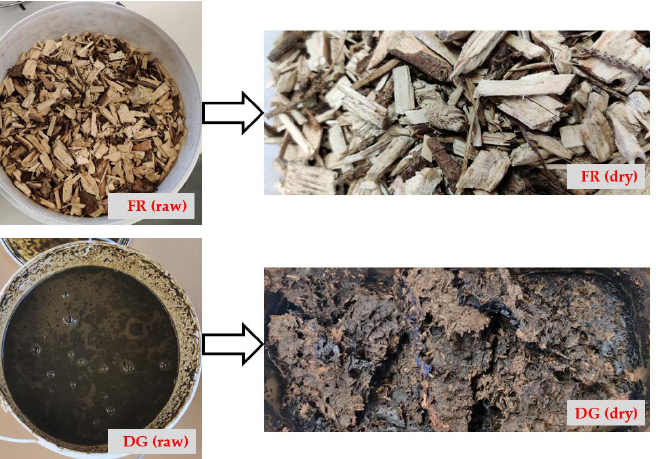
Figure A1. Raw materials used in this study: softwood-based forest residue (FR) and digestate (DG); left pictures: samples as provided; right pictures: samples as dry material.